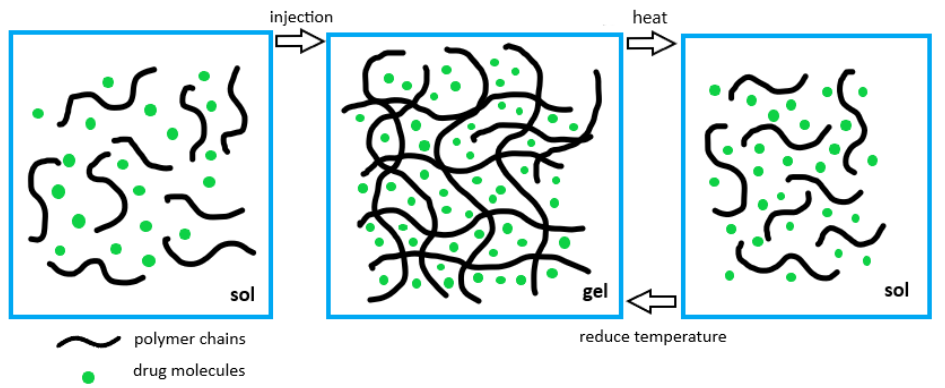
Figure 1. Sol–gel–sol transitions of the injectable hydrogels. The sol turns to gel upon body injection while the formed gel can be converted to sol by local heat.